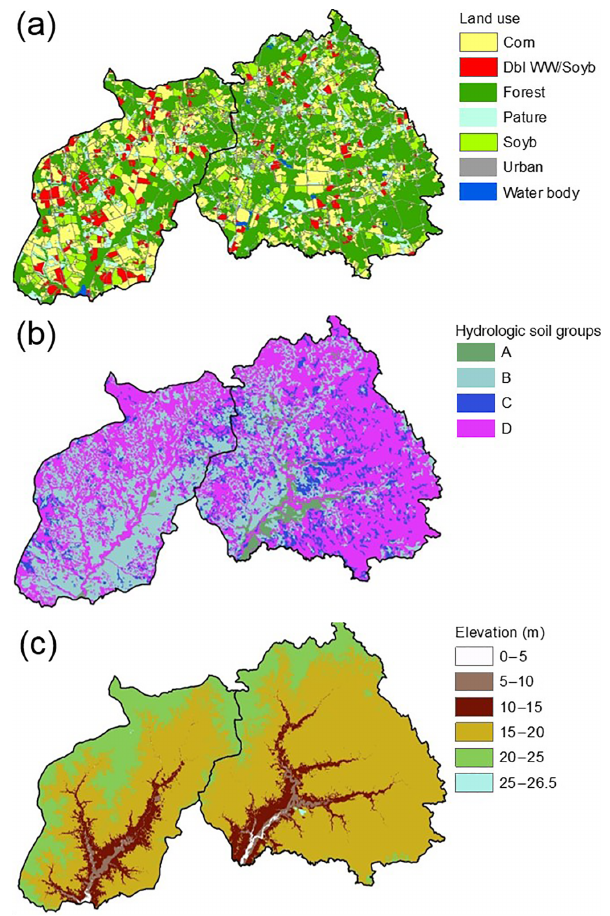
Figure 2. The physical characteristics of the Tuckahoe Creek Watershed (left) and Greensboro Watershed (right); (a) land use, (b) hydrologic soil groups, and (c) elevation (adapted from Lee et al., 2016a). Note: Dbl WW/Soyb stands for double crops of win- ter wheat and soybean in a year. Hydrologic soil groups (HSGs) are characterized as follows: Type A – well-drained soils with a 7.6–11.4mmh − 1 water infiltration rate; Type B – moderately well- drained soils with 3.8–7.6mmh − 1 ; Type C – moderately poorly drained soils with 1.3–3.8mmh − 1 ; Type D – poorly drained soils with 0–1.3mmh − 1 (Netisch et al., 2011).